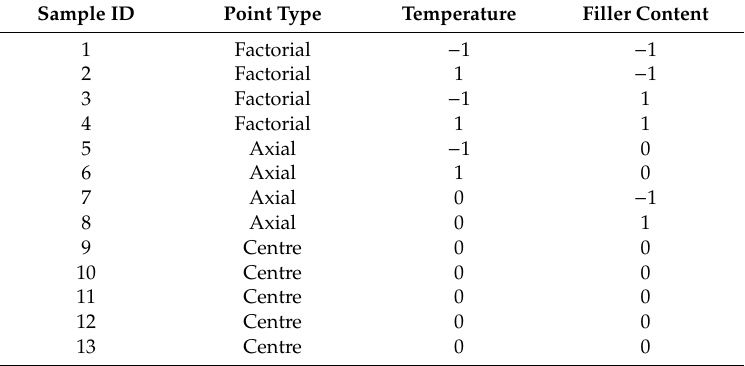
Table 1. Face-centered central composite design (FCCD) used for the optimization of temperature and filler content independent factors with coded values.